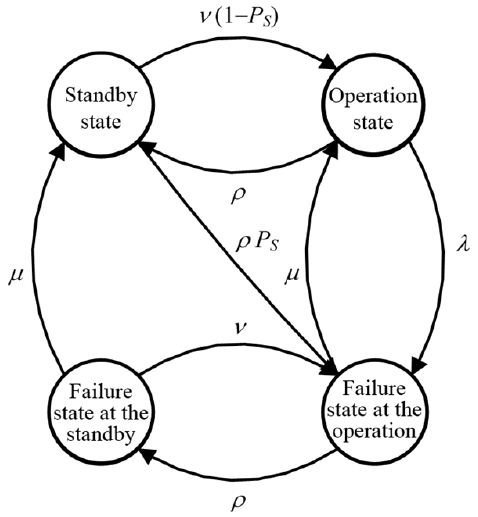
Figure 1. Four-state reliability model of a conventional generation unit operating in peak service. P S is a probability value of unsuccessful unit starting, ν is an operation rate, ρ is a standby rate, λ is a failure rate and µ is a repair rate [63]. Table 2. Reliability parameters of EDG and TDG [64]. Parameter